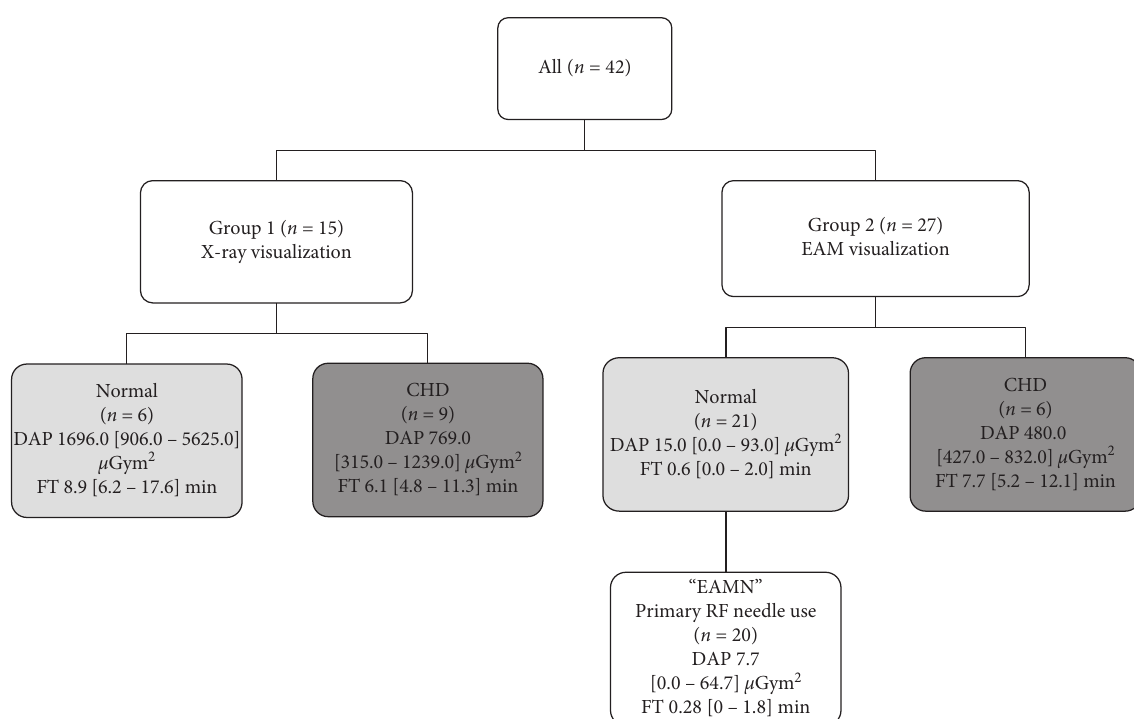
Figure 1: Flowchart of the different patient groups. DAP: Dose Area Product, FT: fluoroscopy time, EAM: electroanatomical mapping, and CHD: congenital heart disease.